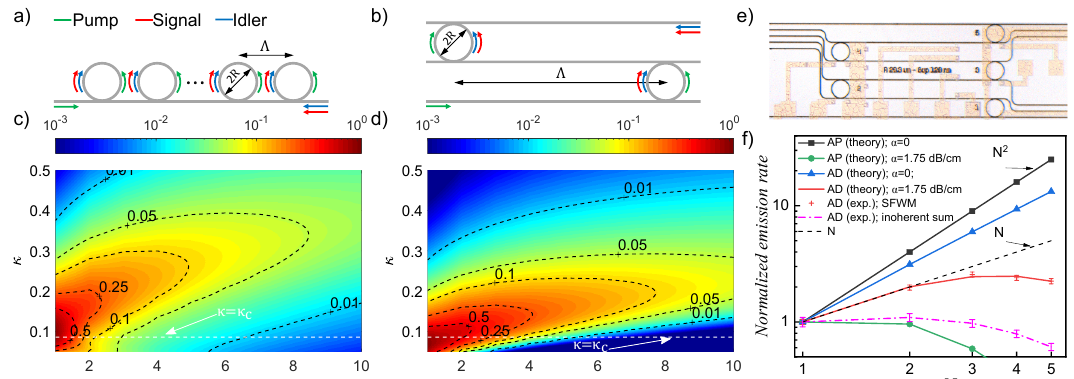
Figure 1: Schematic of a SC all-pass (a) and a DC add-drop (b) ring resonator sequence. Radii of the rings are R and the rings are separated by Λ . Asymptotic-in fields for pump, signal and idler waves are respectively shown by green, red and blue arrows. Photon pair generation rate | β | 2 for all-pass (c) and add-drop (d) configurations in presence of loss normalized to that of the sequence with the highest generation rate, calculated for di ff erent coupling coe ffi cients ( κ ) and sequence lengths ( N ). (e) Optical microscope image of the fabricated DC ring resonator sequence. The heater layer (gold) is overlaid to that of the waveguides (black). (f) Theoretical and experimental normalized generation rate of the all-pass (AP) and the add-drop (AD) configurations for loss-less and lossy